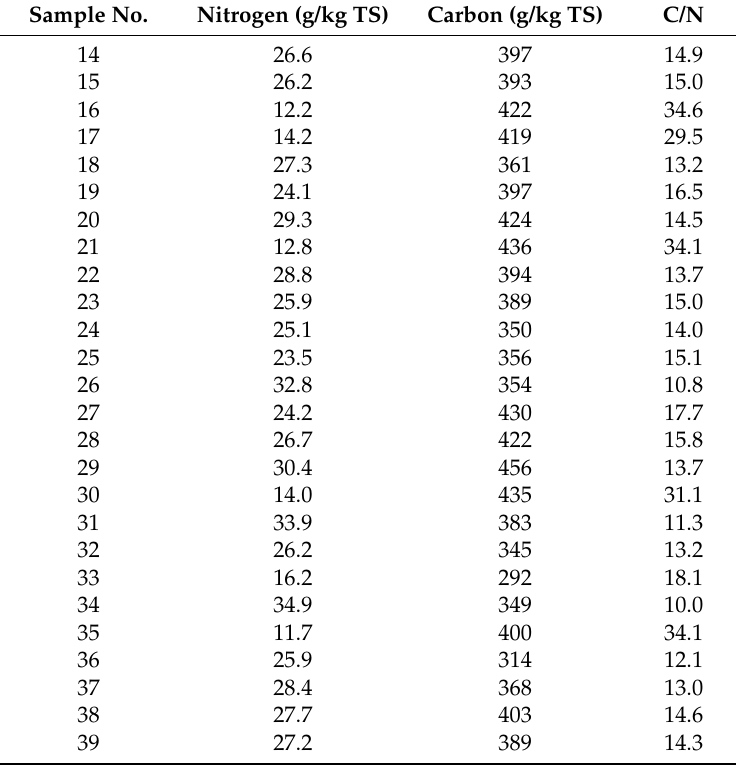
Table 5. Carbon and nitrogen contents in plant material in samples from flowing bodies of water (samples 33–39 are from summer harvesting). Sample